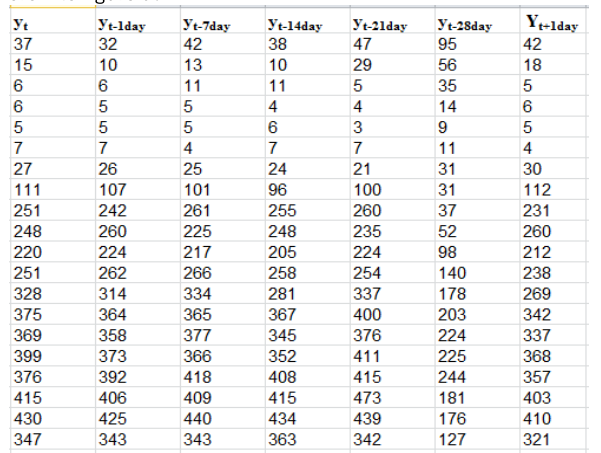
Figure 6 .input and output data of neural network